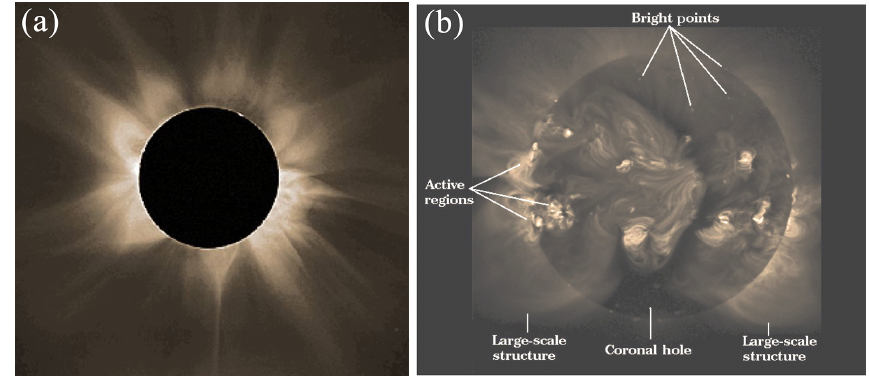
Figure 9. The solar corona as viewed (a) in white light during an eclipse near solar maximum, courtesy of the High Altitude Observa- tory (HAO), University Corporation for Atmospheric Research (UCAR) in Boulder, Colorado. UCAR is sponsored by the National Science Foundation. (b) The solar corona in soft X-rays from the Yohkoh satellite (courtesy of Saku Tsuneta).